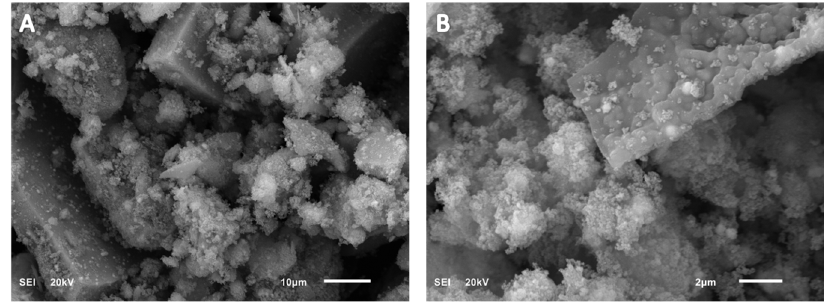
Figure 1. SEM images of PdOTiO 2 at two magnifications: ( A ) 10 µm and ( B ) 2 µm.